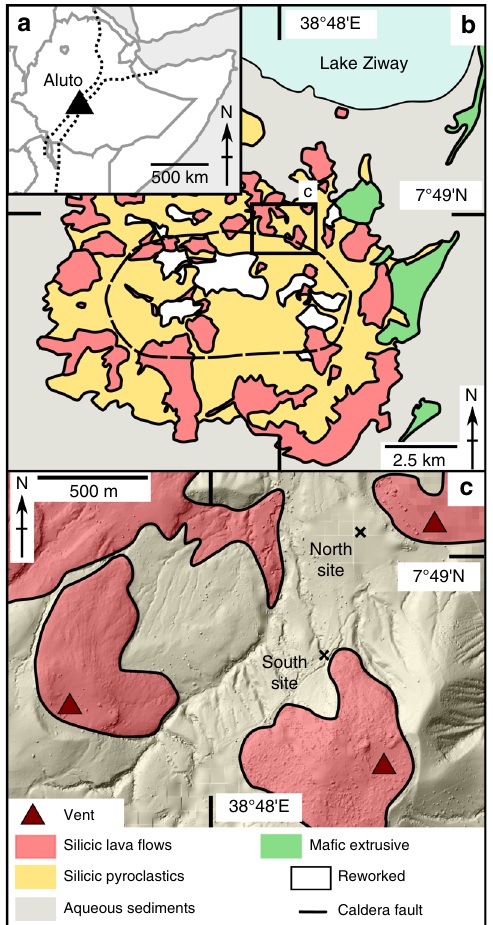
Fig. 1 Contextual and simpli fi ed geological map of Aluto caldera and the sampling sites. a Map showing location of Aluto in Ethiopia. b Simpli fi ed geological map of Aluto after Hutchison, 2015. c DEM hillshade overlain by geology showing north and south study sites. DEM produced using Aluto LiDAR data from ref.